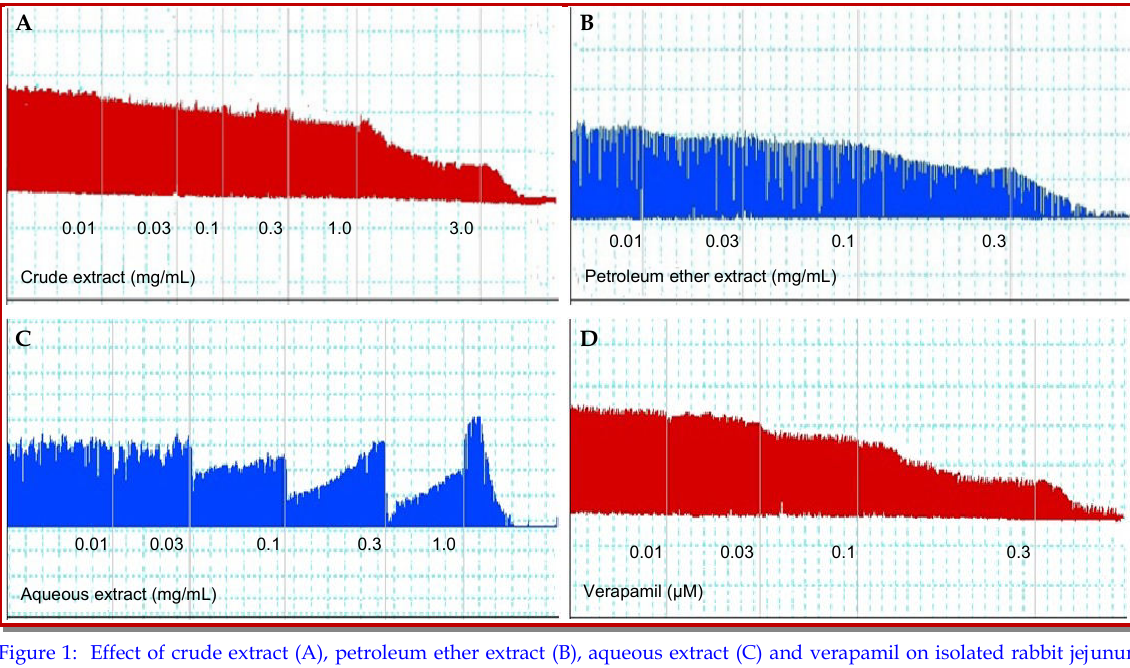
Figure 1: Effect of crude extract (A), petroleum ether extract (B), aqueous extract (C) and verapamil on isolated rabbit jejunum preparations A r o on t C %